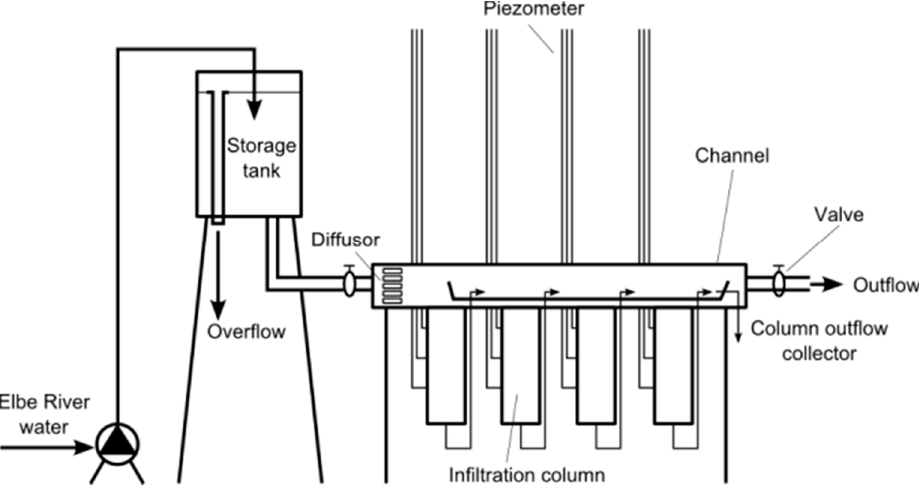
Figure 3. Channel setup (adopted from [13]).